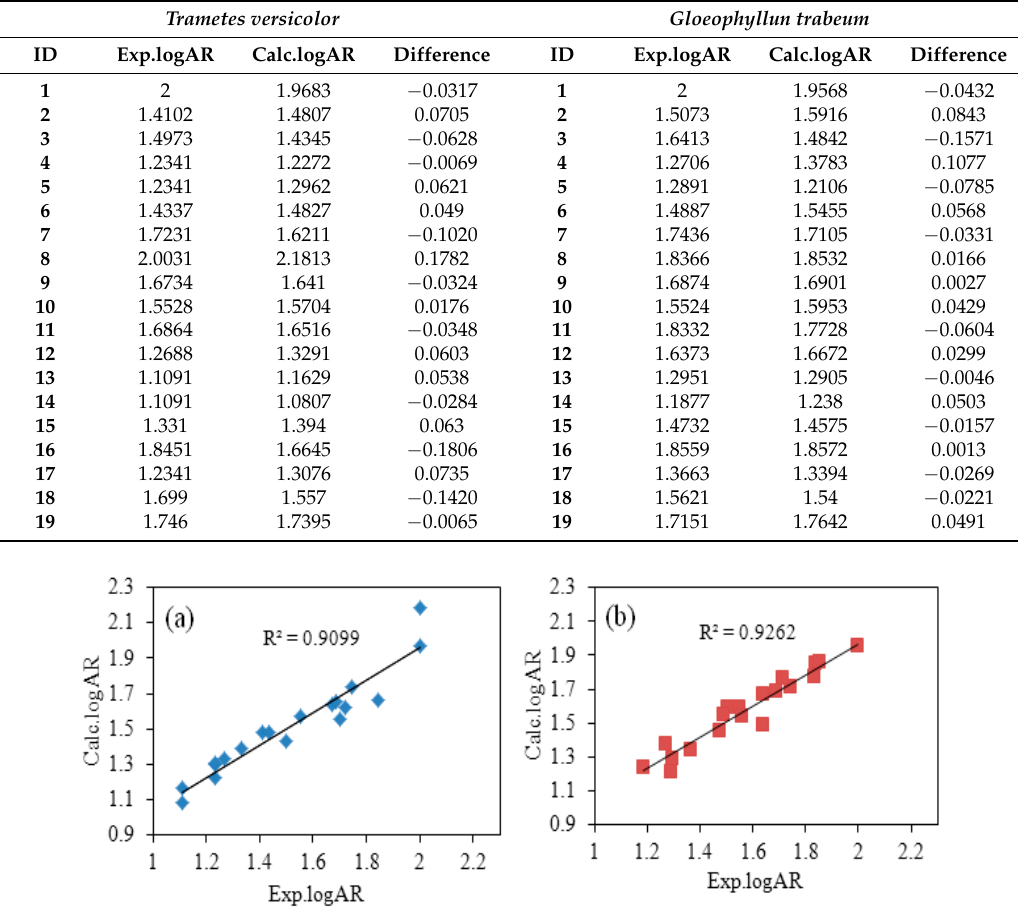
Table 5. Experimental logAR and Calculated logAR for Trametes versicolor and Gloeophyllun trabeum .